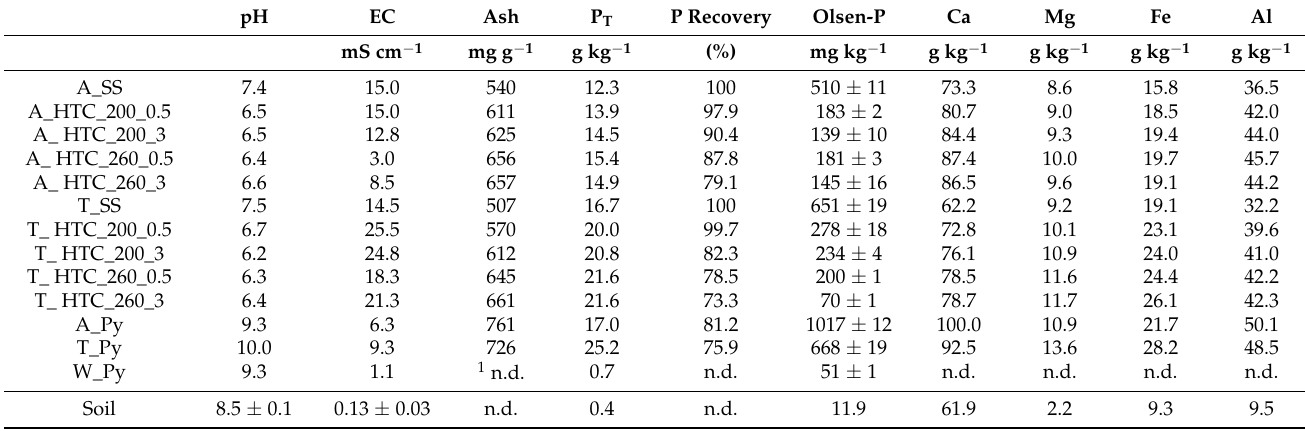
Table 1. The pH, electrical conductivity (EC), ash and total P (P T ) contents, as well as P recovery, concentrations of Olsen-P, Ca, Mg, Fe and Al for primary (A_SS) and secondary (T_SS) sewage sludges, for the respective hydrochars produced at 200 ◦ C and 260 ◦ C for 0.5 h and 3 h (A_HTC 200_0.5/3, A_HTC 260_0.5/3, S_HTC 200_0.5/3, T_HTC, T_HTC 260_0.5/3), the respective pyrochars being A_Py and T_Py, a pyrochar from green waste (W_Py) and for the soil. Except for the soil, the values for pH, electrical conductivity (EC), ash, P T , as well as Ca, Mg, Fe and Al for the hydro/pyrochars are average values provided by the analytical service of the producer. Olsen-P is given as the mean and the respective standard deviation.